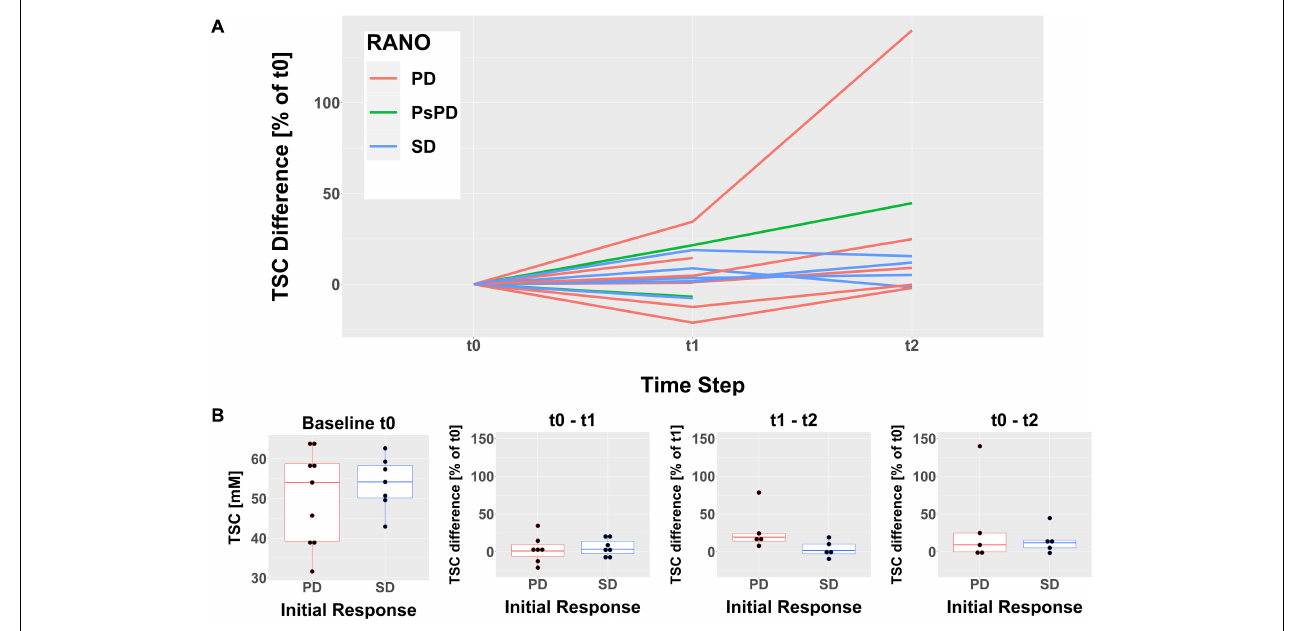
FIGURE 1 | Evolution of the median tissue sodium concentration (TSC) inside the whole tumor areas excluding necrosis following treatment. The time steps refer to the pre-therapy imaging (t 0 ), the follow-up immediately post-therapy (t 1 ) and the follow-up 6 weeks post-therapy (t 2 ). (A) The descriptive analysis shows a heterogeneous evolution of TSC for all patients that does not evidently reflect the RANO response evaluation. The differences between t 0 and t 1 (at time step t 1 ) as well as between t 0 and t 2 (at time step t 2 ) were normalized to the baseline TSC at t 0 . (B) Boxplots showing the median TSC at t 0 (left) as well as the normalized TSC differences between all-time steps grouped by initial response according to RANO. None of the observed intergroup differences reached statistical